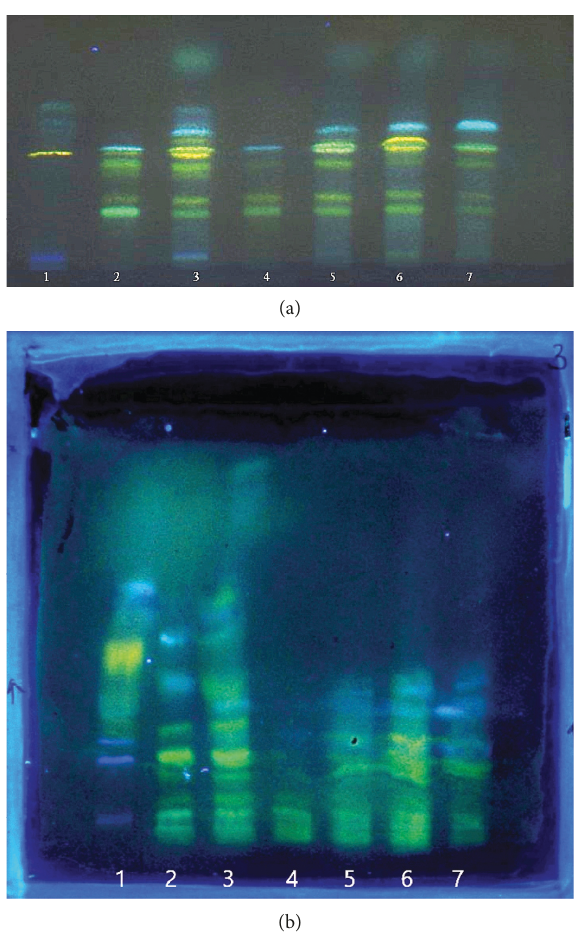
Figure 7: Separation of plant extracts with HPTLC (a) and PPEC (b) techniques. Plant extracts No.: (1) Carduus carlinoides herb, (2) Carduus carlinoides flowers, (3) Carduus carlinoides inflorescentia methanolic extract fraction Fb, (4) Carduus nigrescens flowers, (5) Carduus nigrescens flowers methanolic extract fraction Fb, (6) Cirsium canum flowers, (7) Cirsum deccusatum flowers. Experiment conditions: the mobile phase: 0.040M SDS, pH 7.0 (0.88 mM of citric acid and 8.23mM of disodium hydrogen phosphate), 1.2M butanol, and 10% v/v acetonitrile; the stationary phase: HPTLC RP-18W. PPEC experiment: polarization voltage 1400V; experiment time 8min. Detection after derivatization at λ �